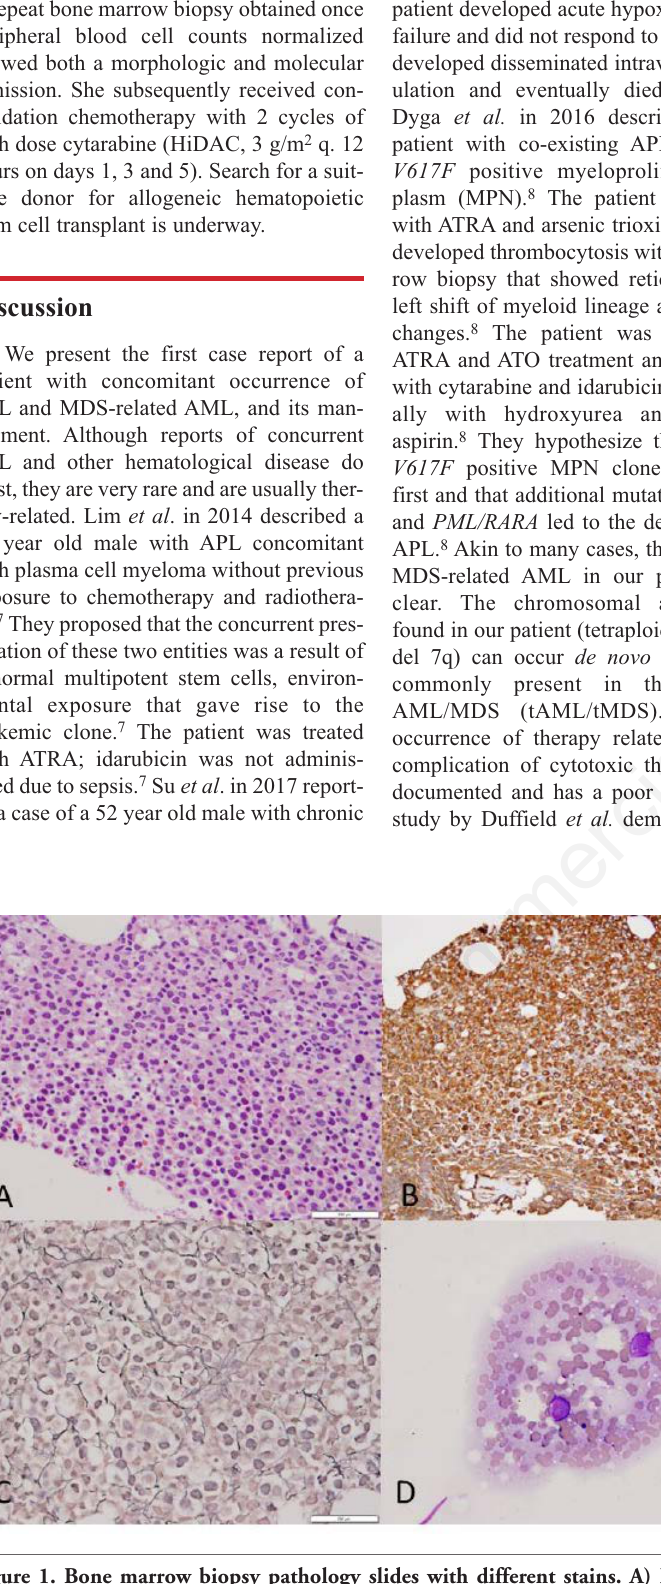
Figure 1. Bone marrow biopsy pathology slides with different stains. A) Bone marrow biopsy 100X hematoxylin and eosin stain showing a hypercellular marrow with increased promyelocytes; B) Bone marrow biopsy 200X MPO stain showing diffuse MPO staining; C) Bone Marrow Biopsy 400X reticulin stain showing grade 1 fibrosis; D) Roll prepara- tion 400X Wright stain showing promyelocyte